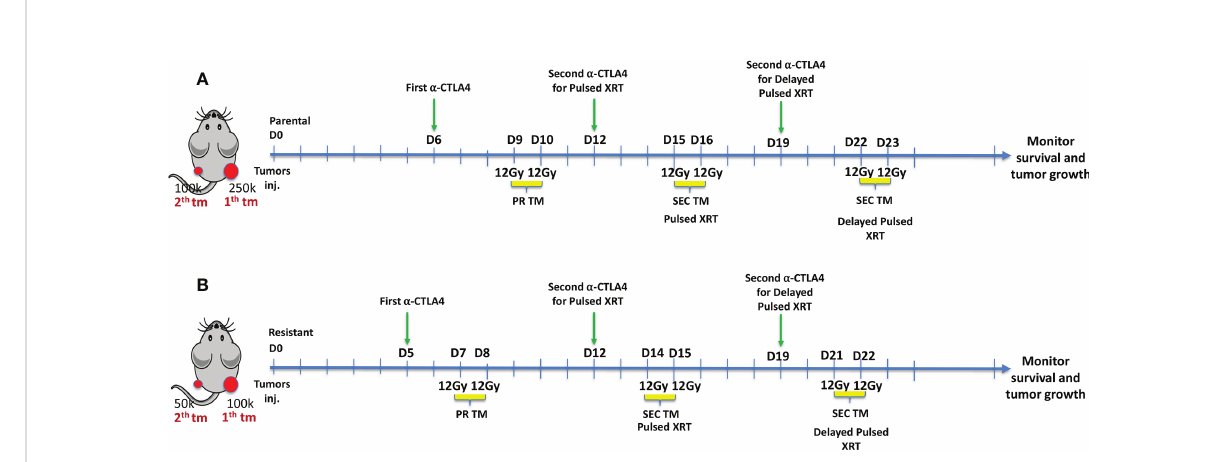
FIGURE 1 (A) Experimental design for Pulsed XRT (12Gy given on days 9, 10, 15, 16) and Delayed Pulsed XRT (12Gy given on days 9, 10, 22, 23) in 344SQ- Parental murine model. (B) Experimental design for Pulsed XRT (12Gy given on days 7, 8, 14, 15) and Delayed Pulsed XRT (12Gy given on days 7, 8, 21, 22) in 344SQ-Resistant